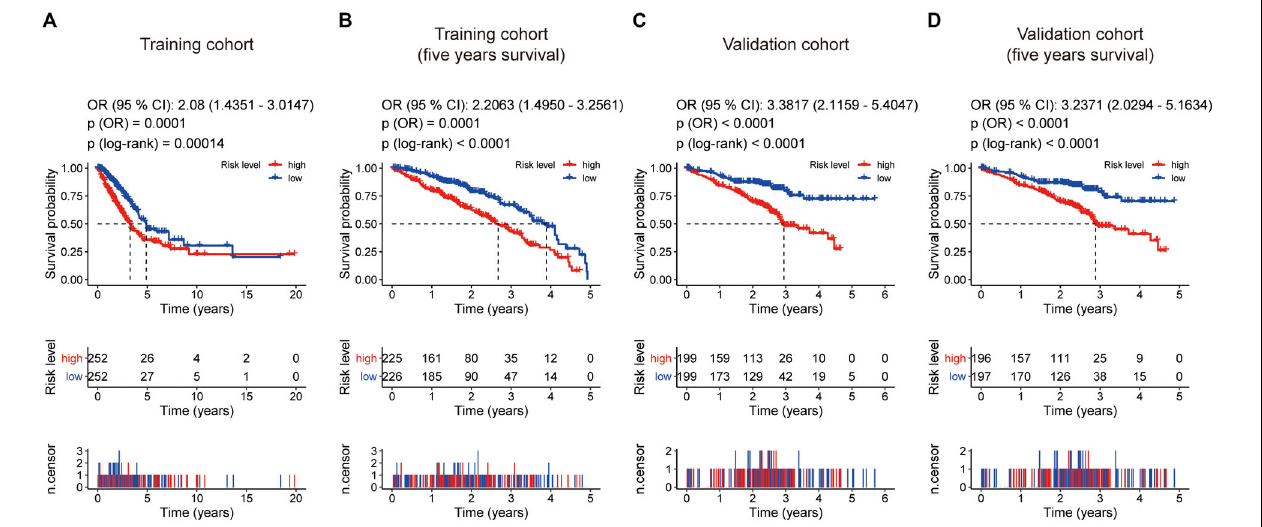
FIGURE 4 | Kaplan–Meier survival analyses based on the eight-gene signature. (A) Training cohort based on overall survival. (B) training cohort based on 5-year overall survival. (C) Validation cohort based on overall survival. (D) Validation cohort based on 5-year overall survival. The differences between the two curves were determined by the two-side log-rank test with a p value < 0.05. The odds ratio (OR) and its 95% confidence interval (95% CI) were calculated accordingly. The number of patients at risk is listed in the middle of each